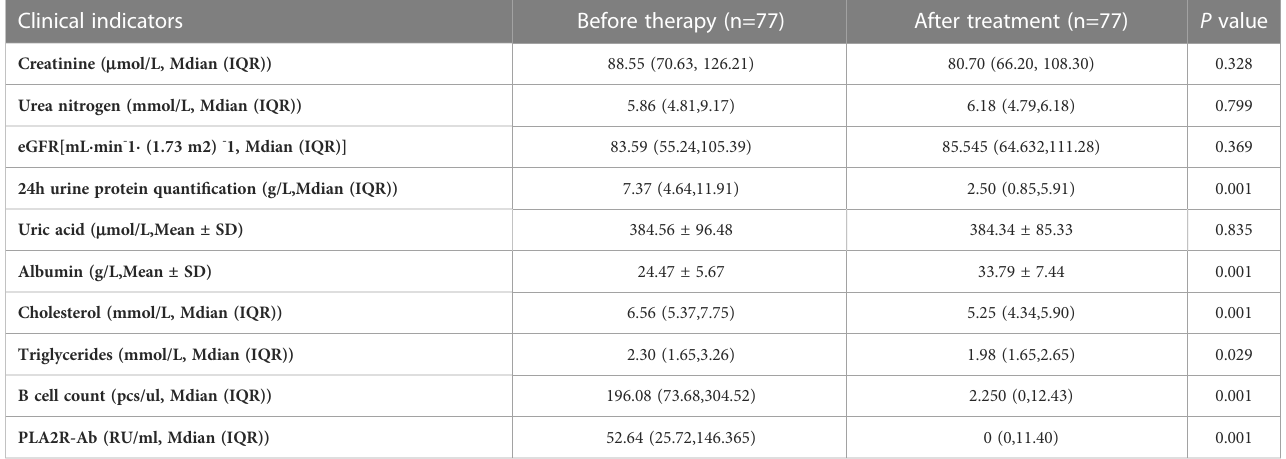
TABLE 3 Comparison of clinical data before and after treatment between the two groups of patients.